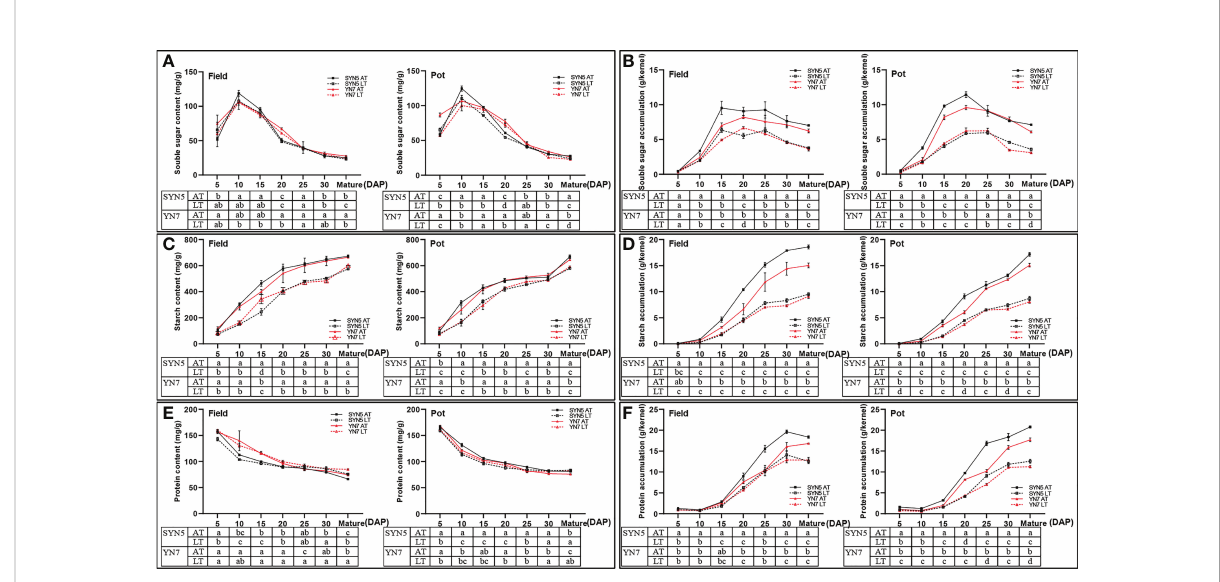
FIGURE 3 Effect of post-silking LT on the soluble sugar, starch and protein contents and accumulation in waxy maize grains during grain fi lling stage. (A) , soluble sugar content; (B) , soluble sugar accumulation; (C) , starch content; (D) , starch accumulation; (E) , protein content; (F) , protein accumulation. Error bars denote standard errors from three replicates, and different letters at the same sampling date indicate signi fi cant difference at P <